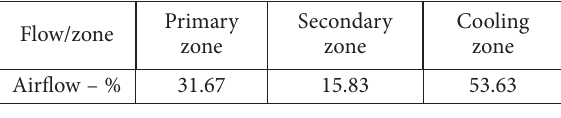
Table 1. Air zones (source: Silva & Lacava,